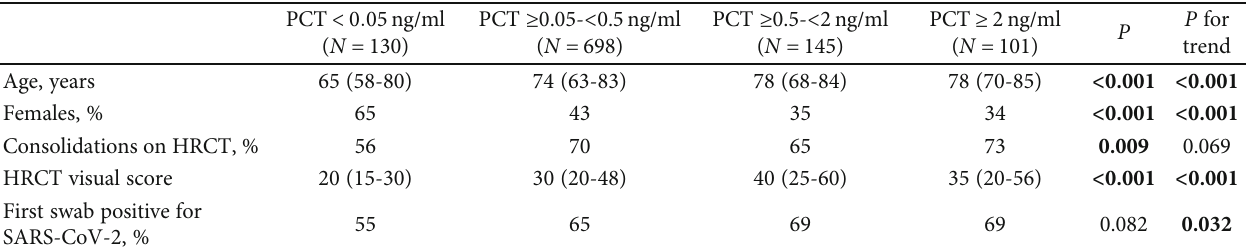
Table 1: Overview of the main demographical, radiological, and virological characteristics on admission of the 1074 patients included in the study, strati fi ed according to procalcitonin levels on